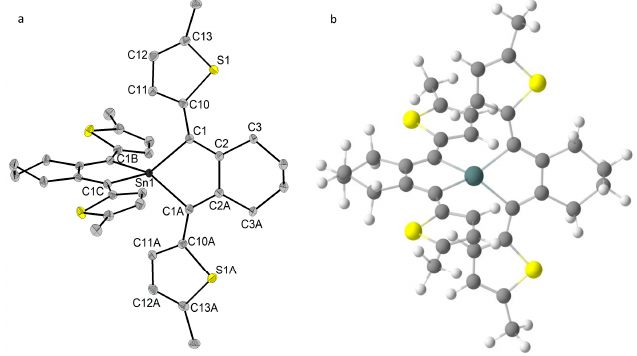
Figure 1. ( a ) Molecular structure of spirostannole 4 , showing 50% probability ellipsoids and the crystallographic numbering scheme. All hydrogen atoms were omitted for clarity. ( b ) Optimised geometry of spirostannole 4 based on DFT calculations.